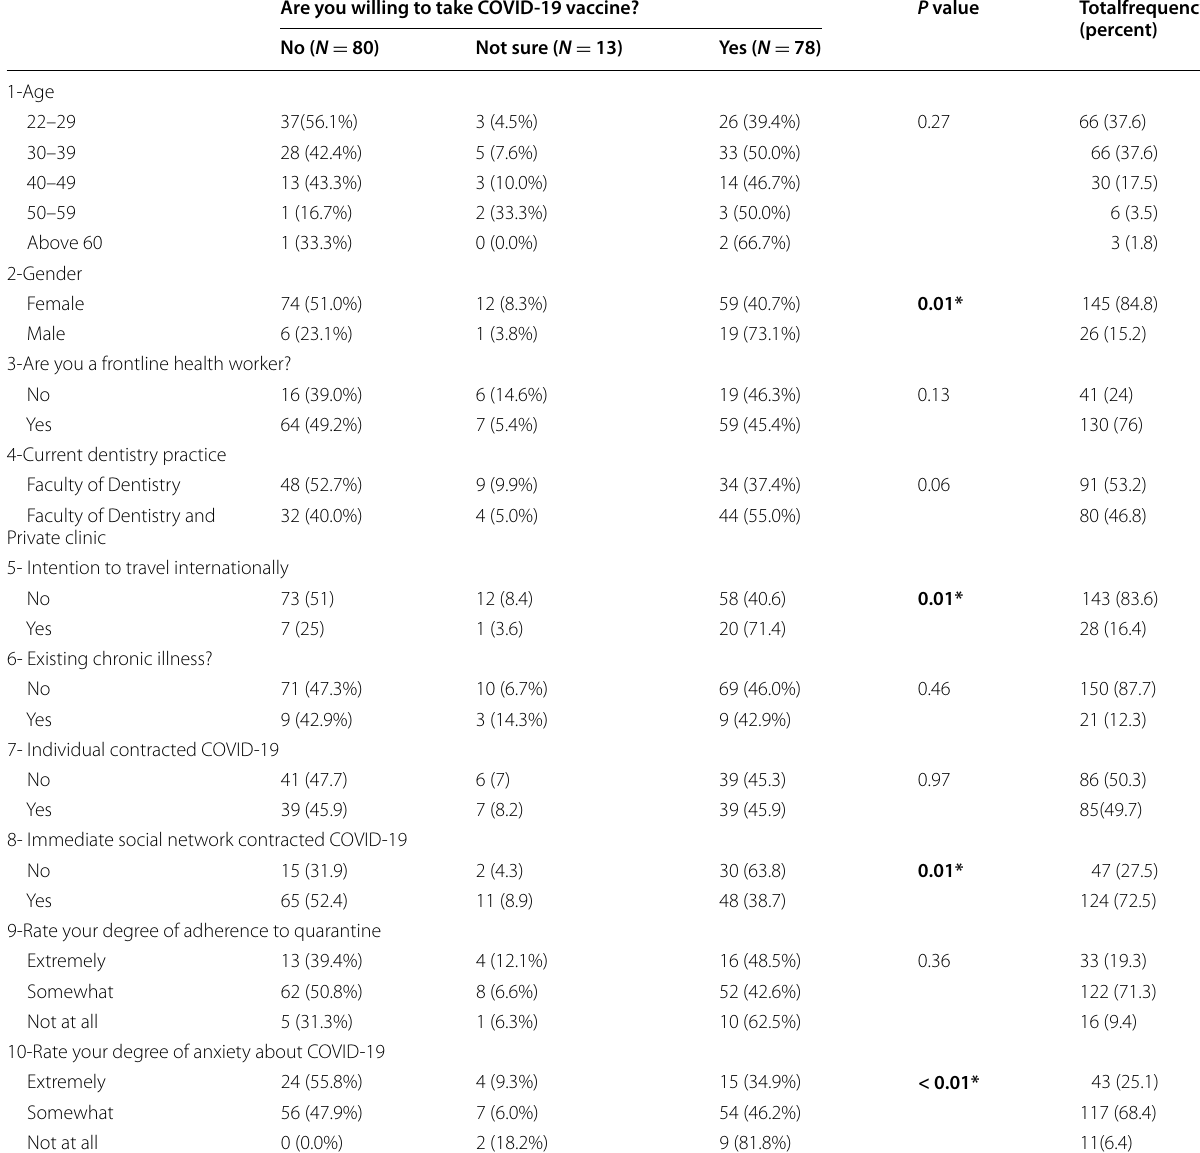
*Statistically significant differences. All data was analyzed using Fisher’s exact test